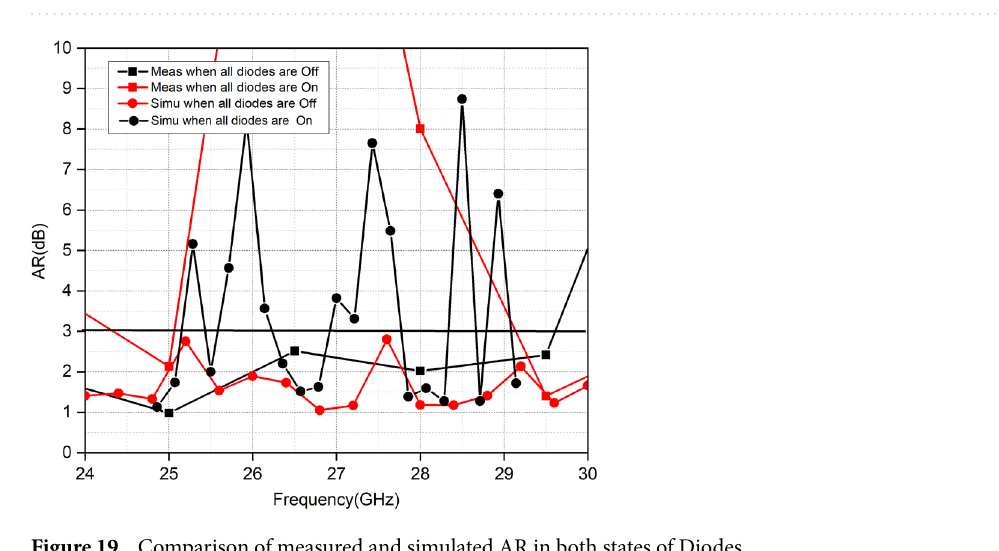
Figure 19. Comparison of measured and simulated AR in both states of